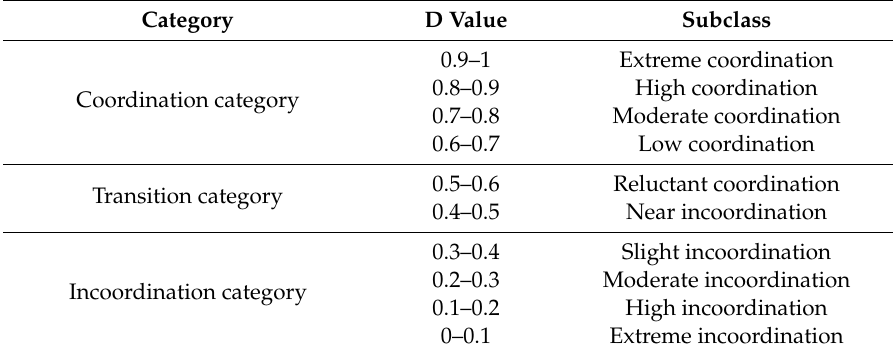
Table 2. Classification standard and the types of coupling coordination degree